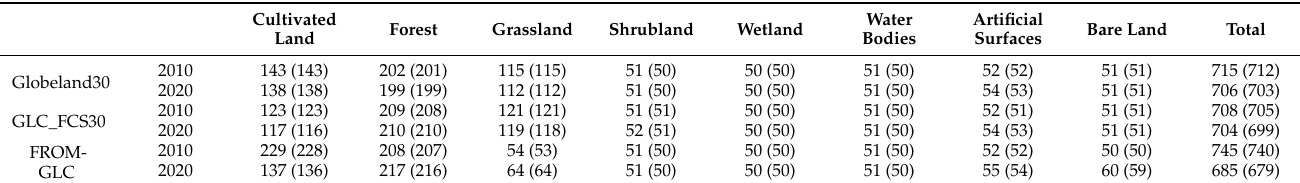
Table 2. Allocation of training sample size to strata of individual base products. Test sample sizes are shown in